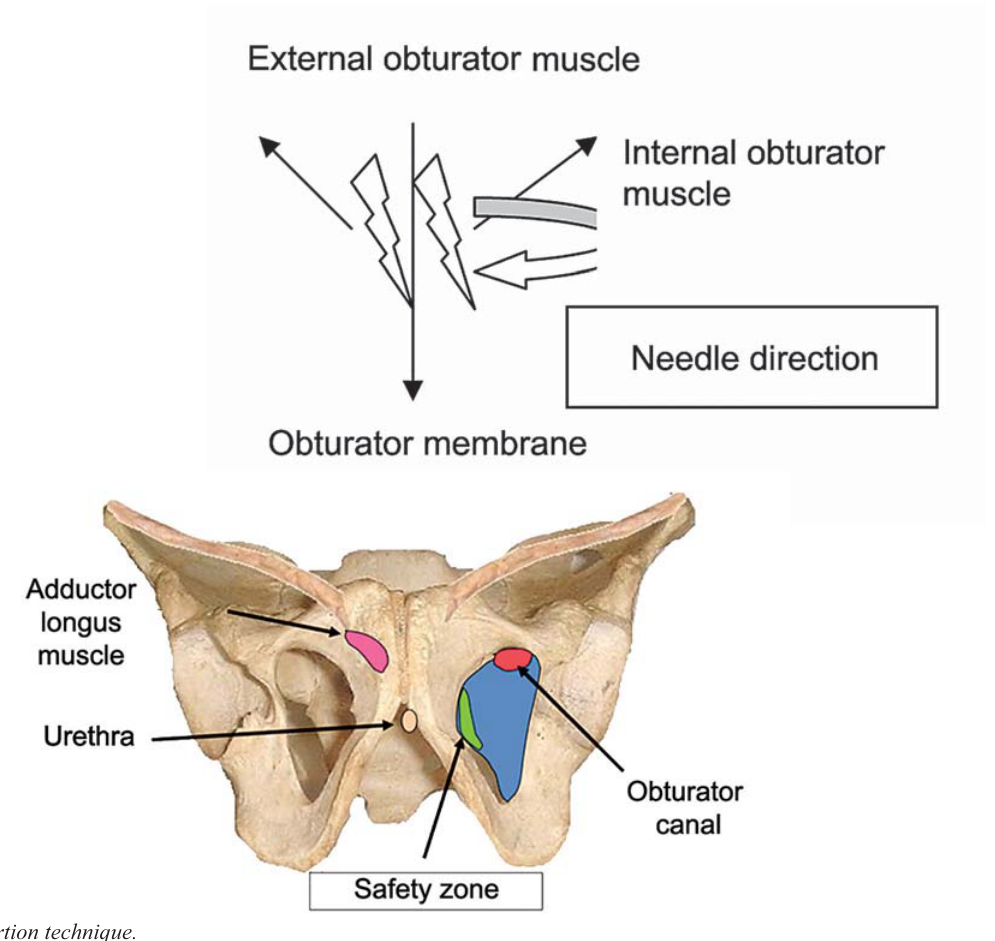
Figure 3 – Tape insertion